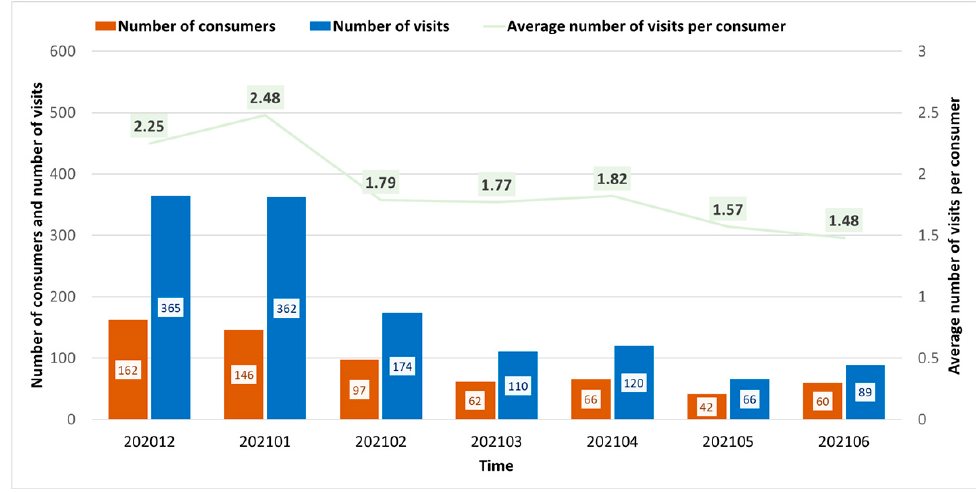
Figure 9. Number of portal visits per consumer over time.